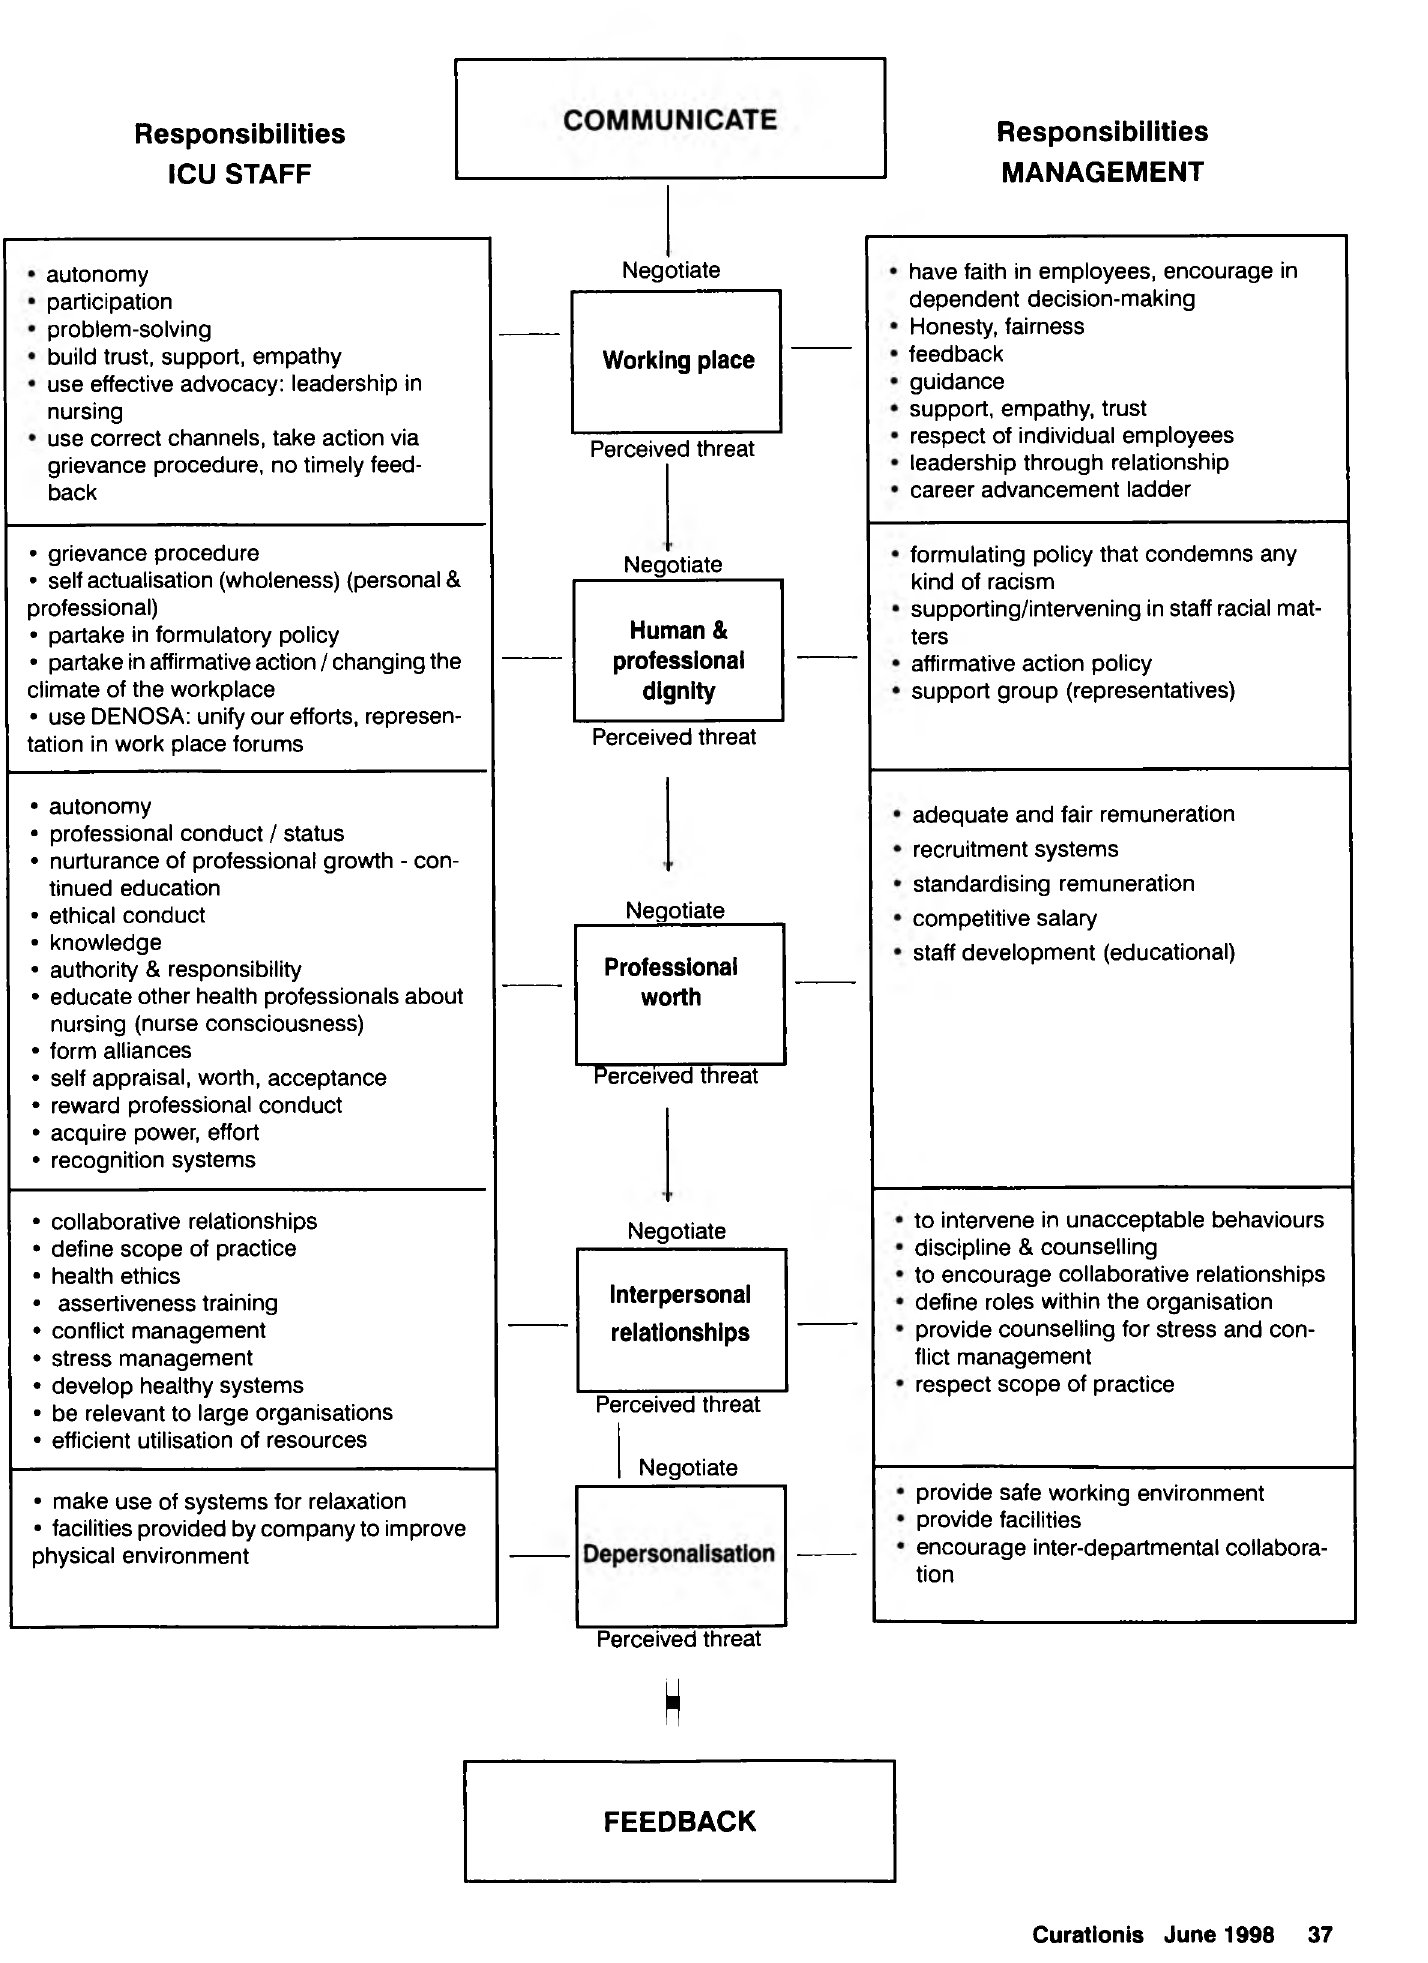
TABLE 3: OVERVIEW OF STRATEGIES TO SUPPORT THE ICU STAFF